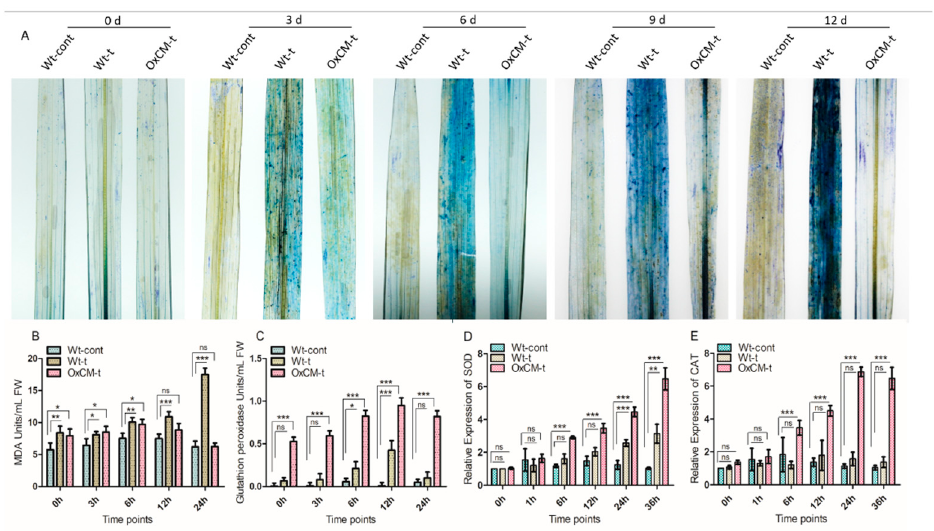
Figure 5. Over-expression of the chorismate mutase gene enhances resistance toward white-backed planthopper (WBPH) stress through the induction of hypersensitive responses and antioxidant machinery. ( A ) Induced hypersensitive responses after 0, 3, 6, 9, and 12 days of WBPH infestation. ( B ) Catalase and ( C ) glutathione peroxidase accumulation in response to WBPH infestation at different time points. ( D , E ) Relative transcriptional accumulation of SOD and CAT genes, respectively, against WBPH infestation. Actin was used as a reference gene. Graph bars indicate the mean ± standard deviation ( n = 3), ns indicates non significant and asterisks indicate significant differences (* p < 0.05, ** p < 0.01, *** p < 0.001) analyzed using two-way analysis of variance and Bonferroni post hoc test. The experiments were repeated three times. Wt-cont; Wt-t, wild-type infected with WBPH; and OxCM-t, chorismate mutase transgenic over-expressor infected with WBPH.